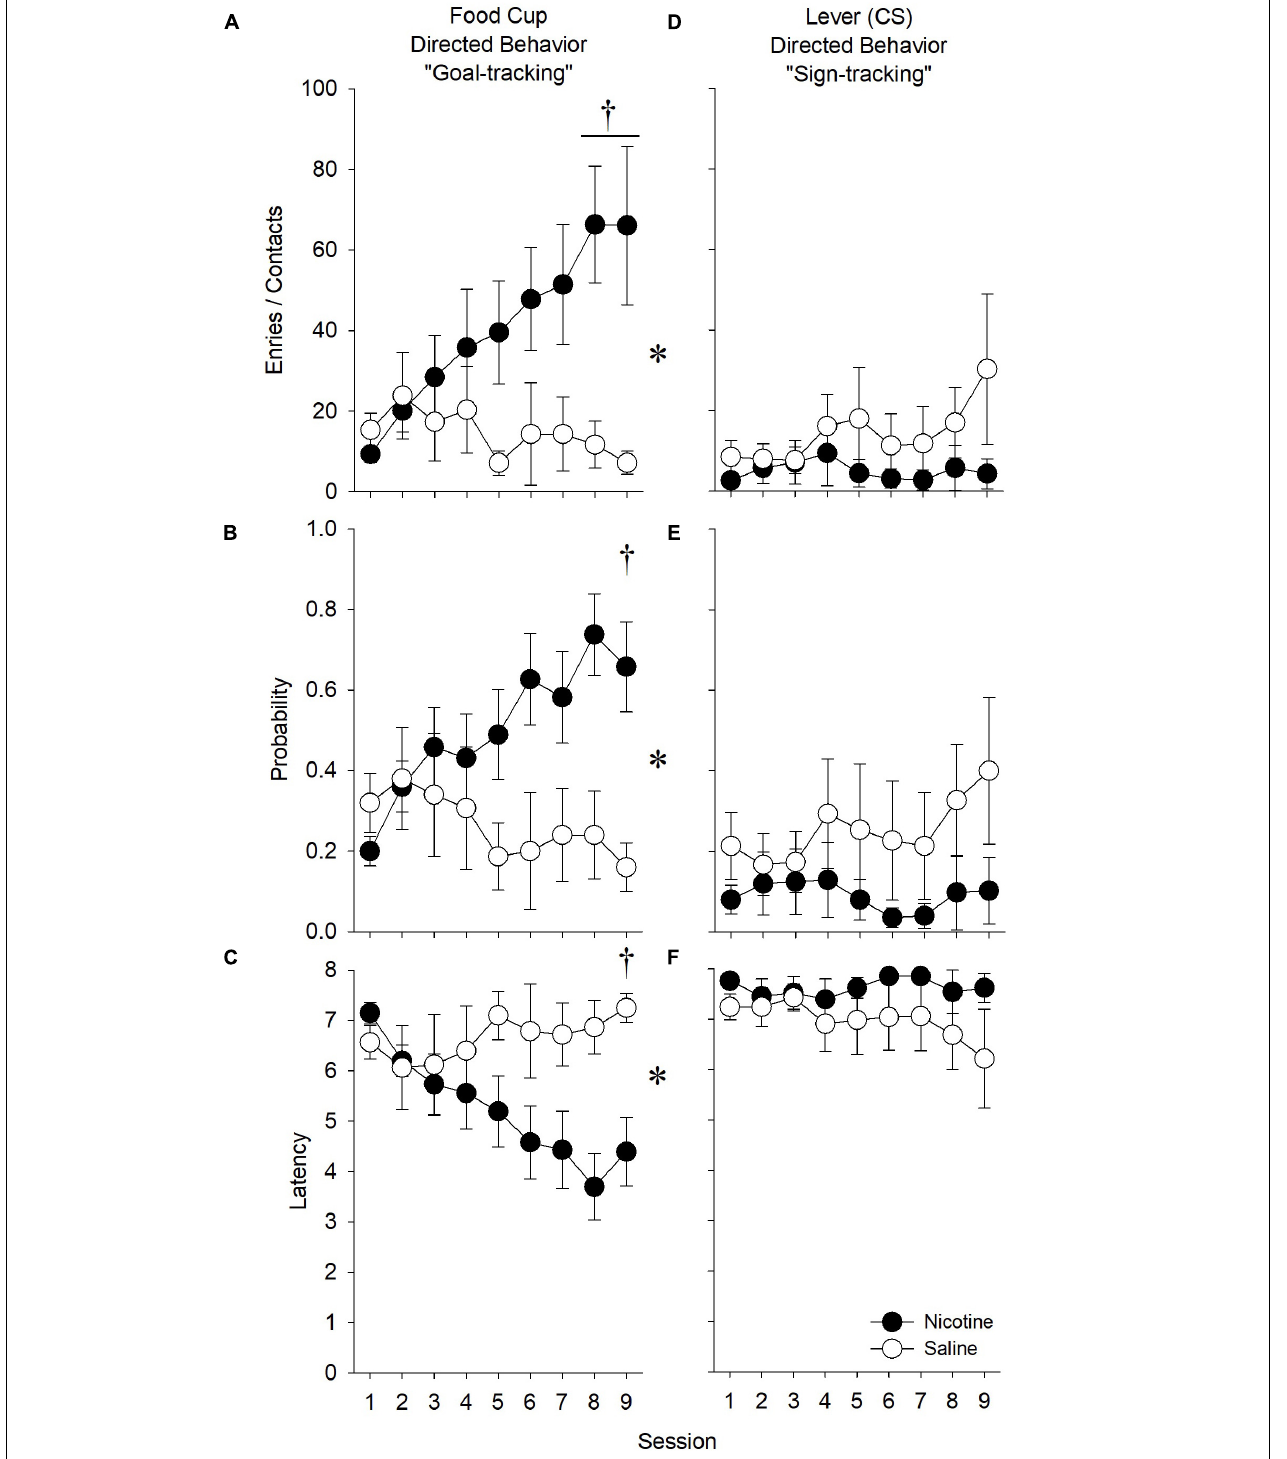
FIGURE 6 | In experiment 2, nicotine enhanced measures of goal-tracking elicited by a food-predictive stimulus relative to saline treatment. During the extension of a lever that predicted the non-contingent receipt of a solid food reward, nicotine (A) increased the number of receptacle entries, (B) increased the probability of making a receptacle entry, and (C) decreased the latency to the first receptacle entry. Conversely, nicotine (D) did not affect the number of lever presses, (E) tended to reduce the probability of contacting the lever, and (F) did not affect the latency to the first lever contact. The effect of nicotine did not differ by Sex for any measure. Asterisk ( ∗ ) indicates significant Treatment × Session interactions, whereas daggers ( † ) indicate significant differences on the indicated test sessions.